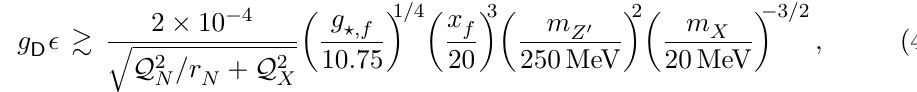
with different values of r N